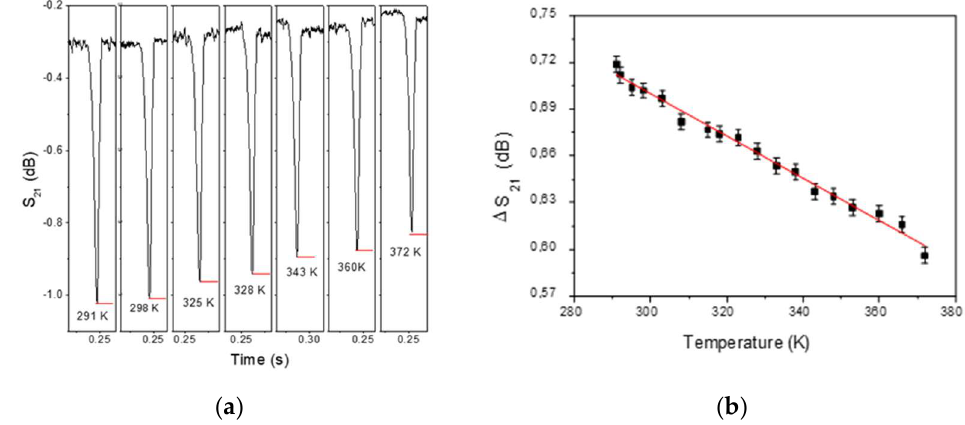
Figure 6. ( a ) Evolution of domain time scattering signal S 12 with measuring temperature for 6 cm length microwire at 2.1 GHZ. ( b ) Linear evolution of peak intensity, ∆ S 21 , with measuring